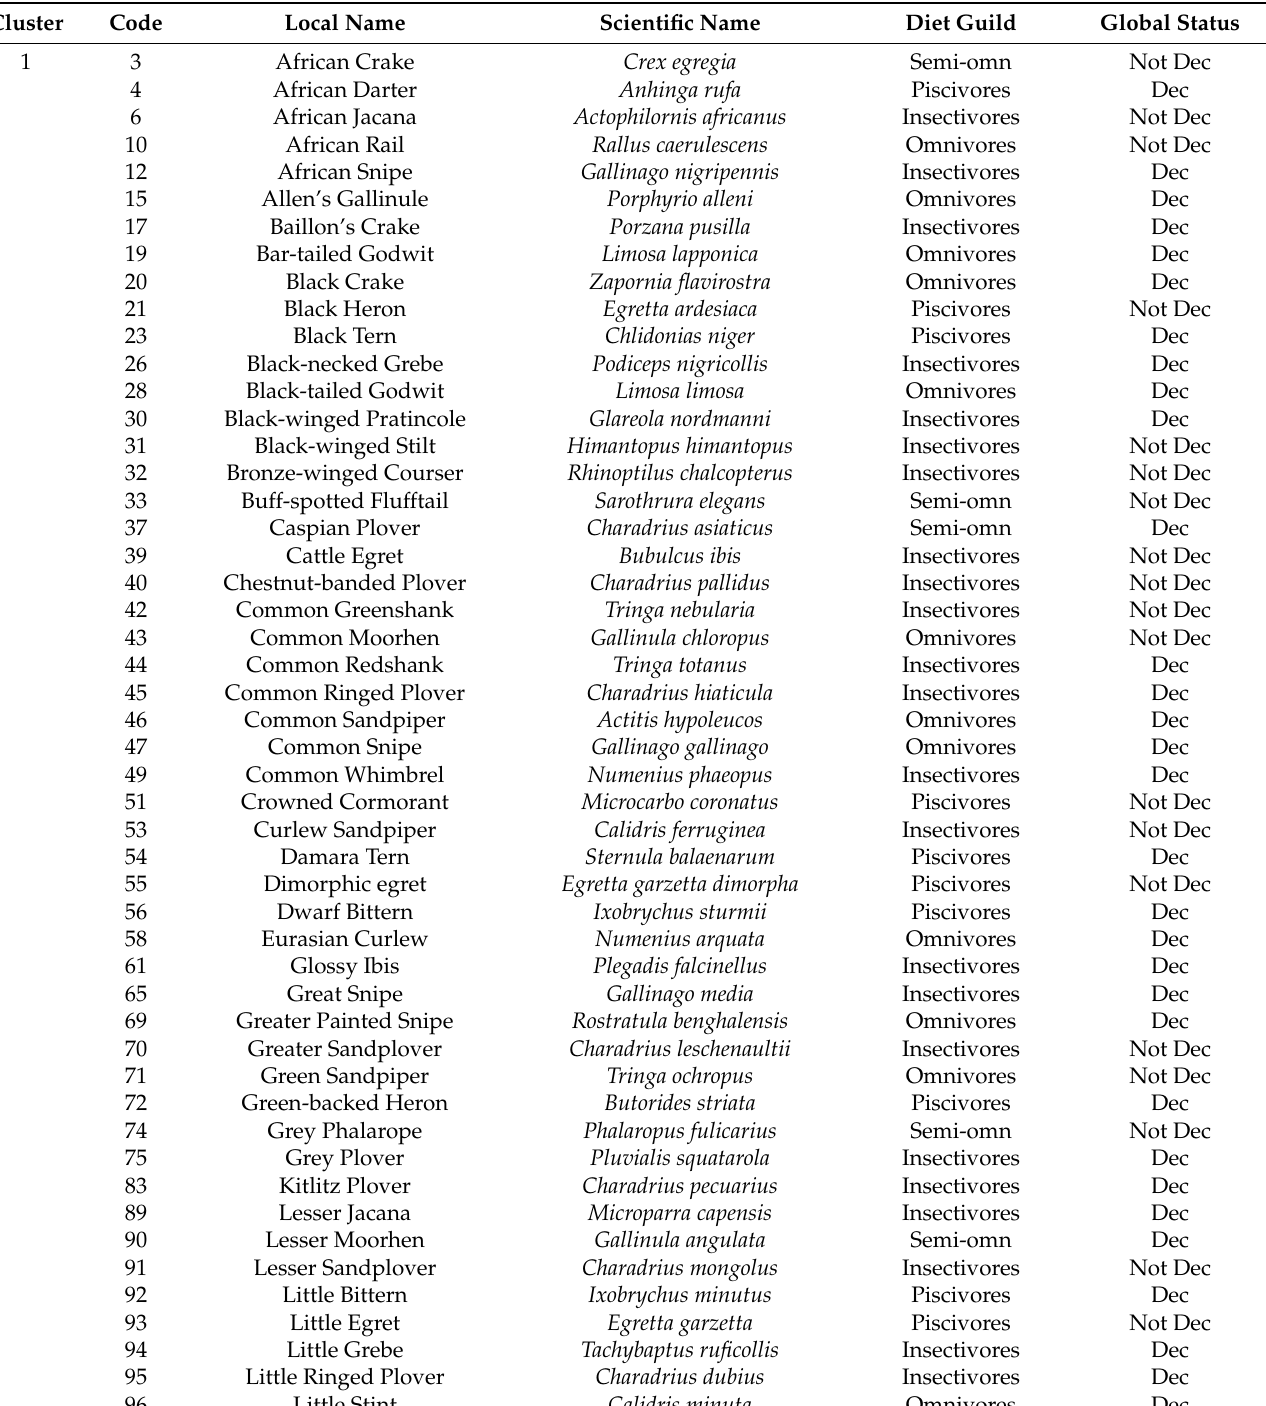
Table A1. Groups of southern African waterbird species from life-history based cluster analysis alongside their re- categorised ecological guilds and codes as used in Figure 1. Semi-omn = semi-omnivores, Dec = declining.